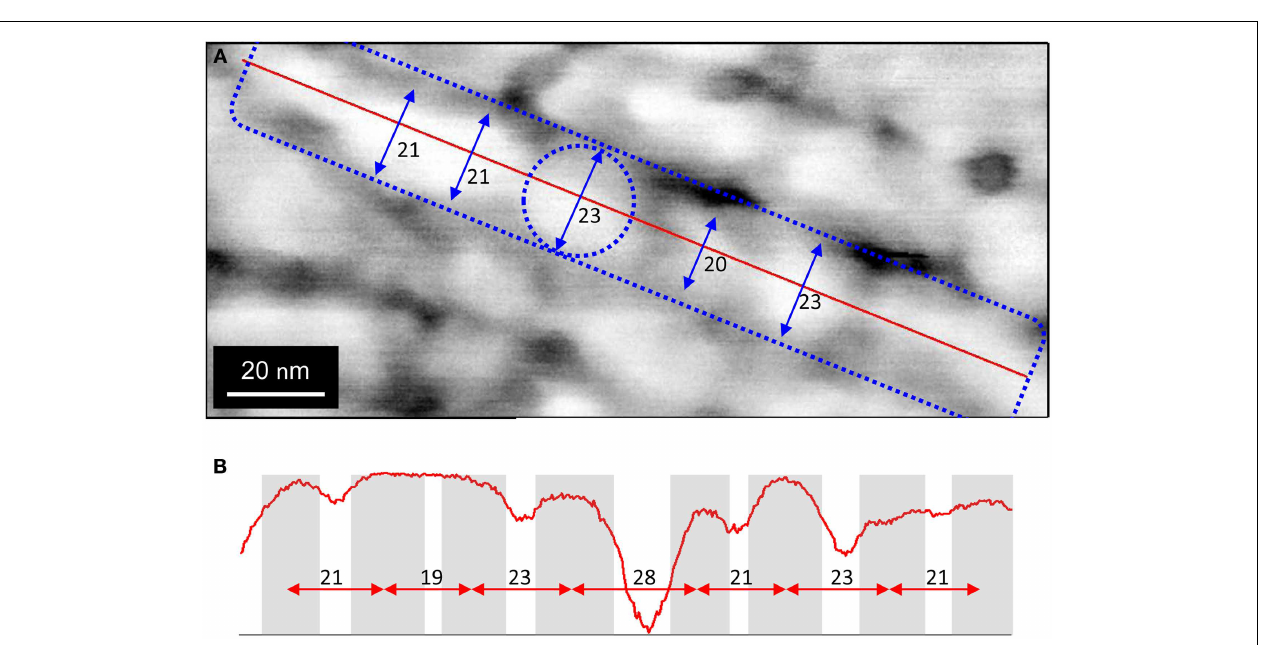
comprising the filament. Blue arrows indicate diameters of adjacent nodules. (B) Phase AFM topological image representing profile along red line in (A) , indicting that nodules are aligned end to end.